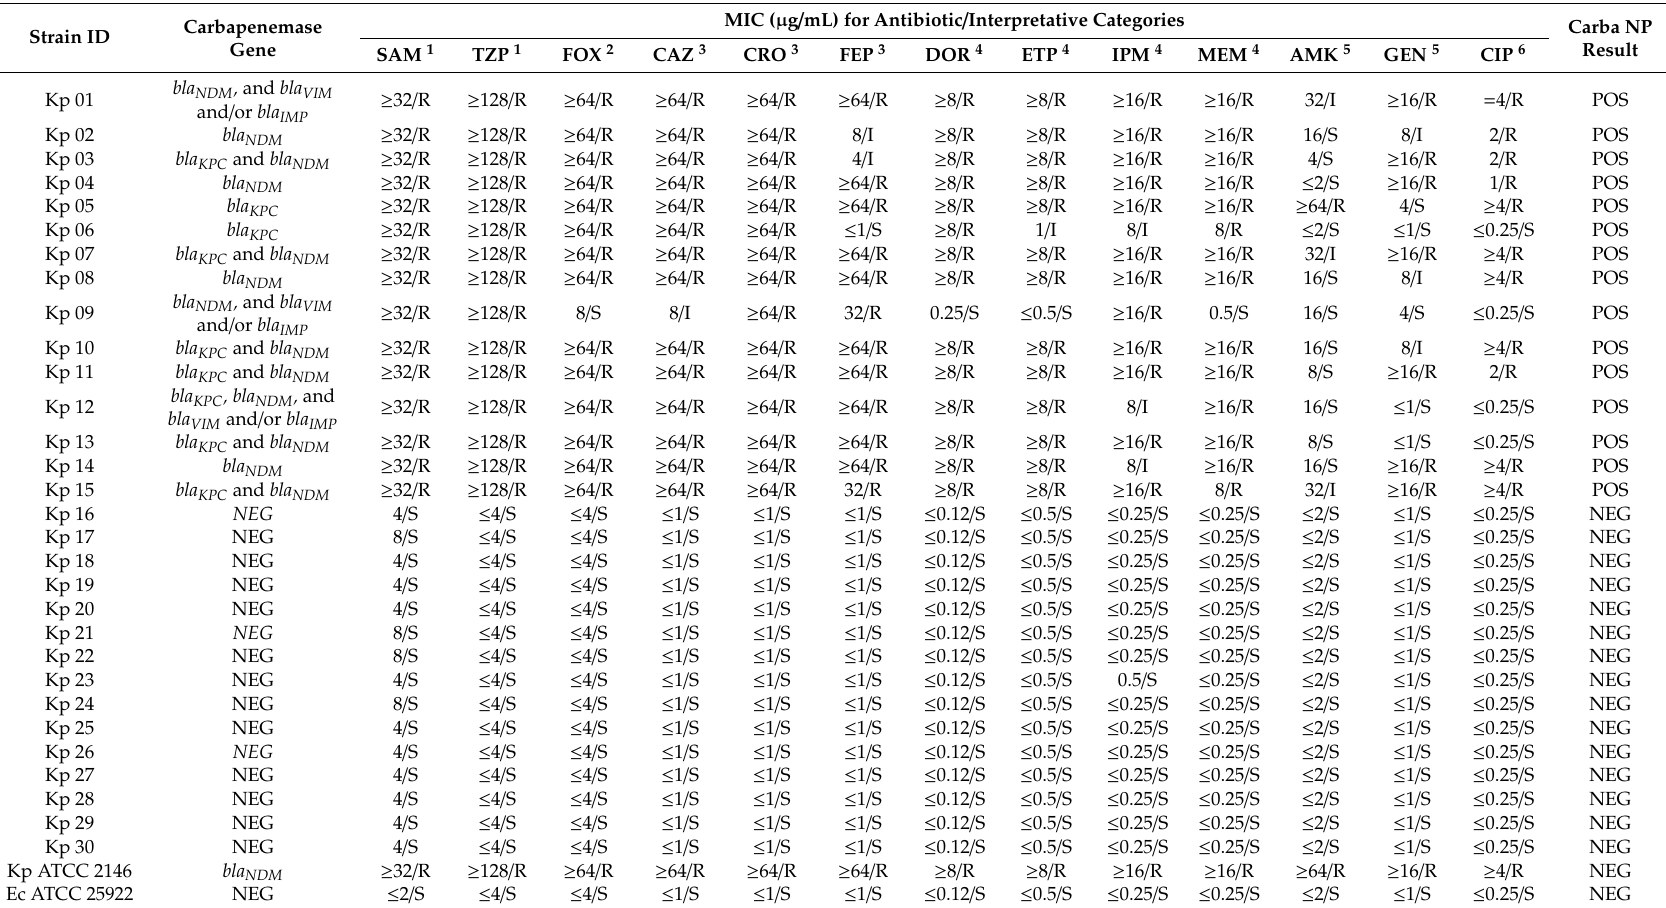
Table 1. Antimicrobial susceptibility and resistance profiles of wild-type and multidrug-resistant strains of K.